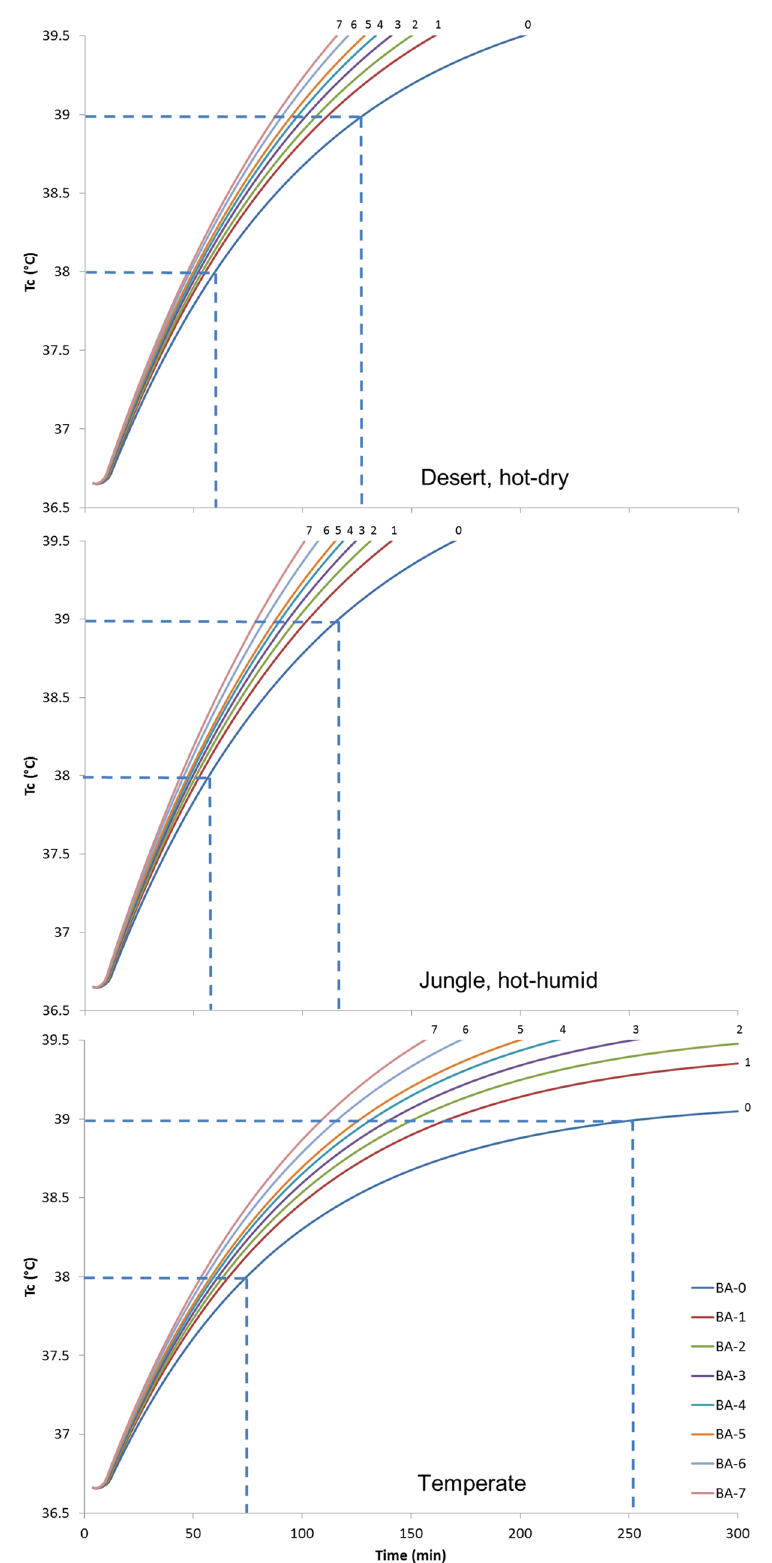
Fig 4. Predicted rise in T c in desert, jungle, and temperate conditions. Foot note: Desert, hot-dry = 49°C, 20%, 1 m/s; Jungle, hot-humid = 35°C, 75%, 1 m/s; Temperate = 35°C, 50%, 1 m/s. doi:10.1371/journal.pone.0132698.g004 PLOS ONE | DOI:10.1371/journal.pone.0132698 July 22,